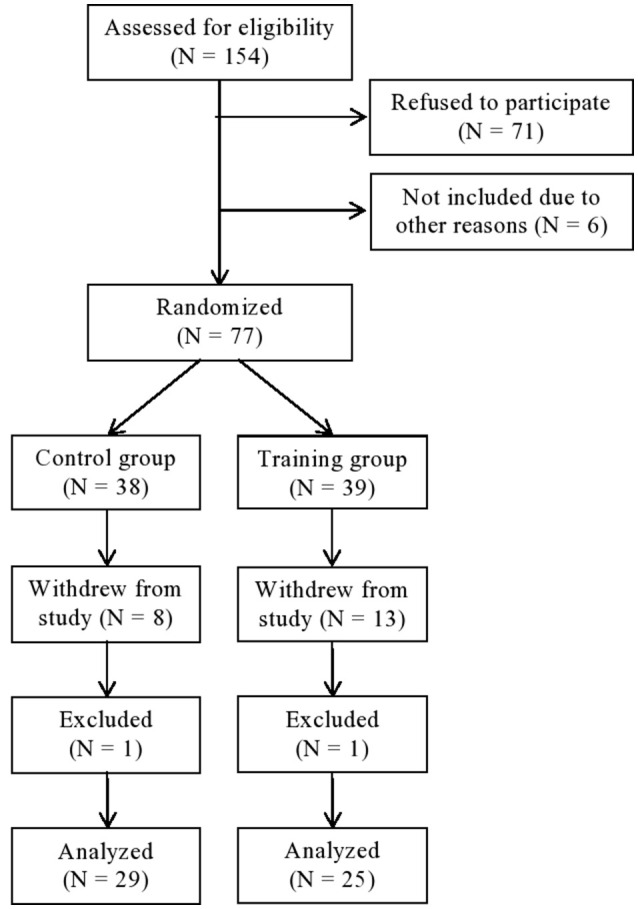
Consort flow chart.